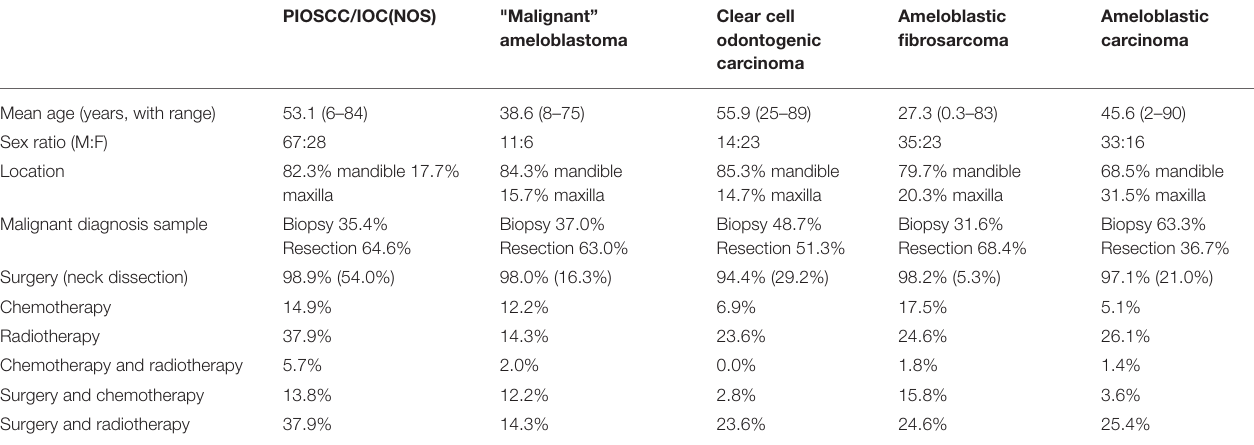
TABLE 2 | Summary of subgroup analysis for the combined first and second histological diagnoses. PIOSCC/IOC(NOS) "Malignant” Clear cell ameloblastoma